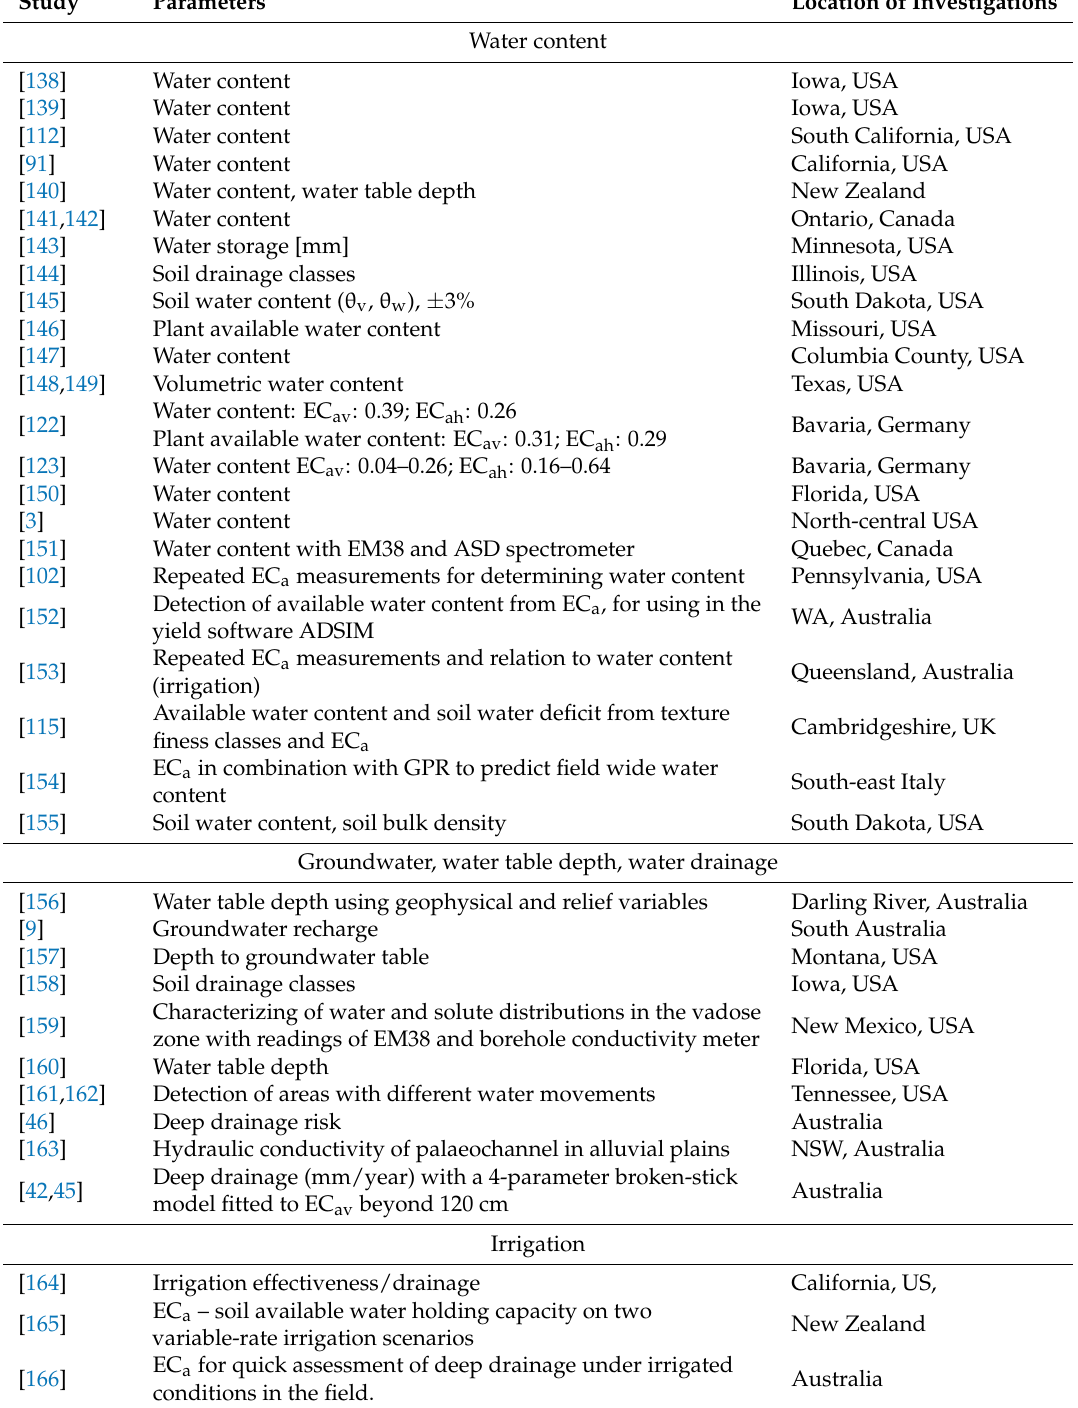
Table 3. Literature describing relationships between EM38-EC a and parameters of soil